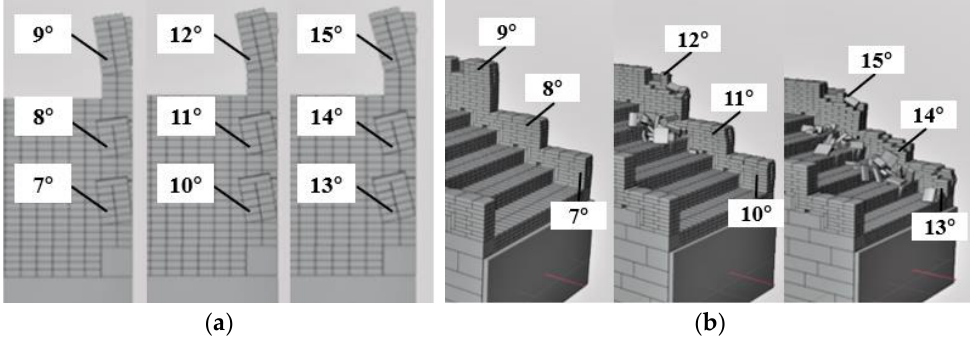
Figure 21. Parapet wall inward tilting: ( a ) Initial; ( b ) Final.